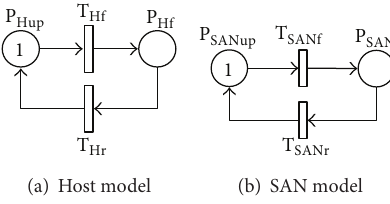
Figure 3: SRN models for host and